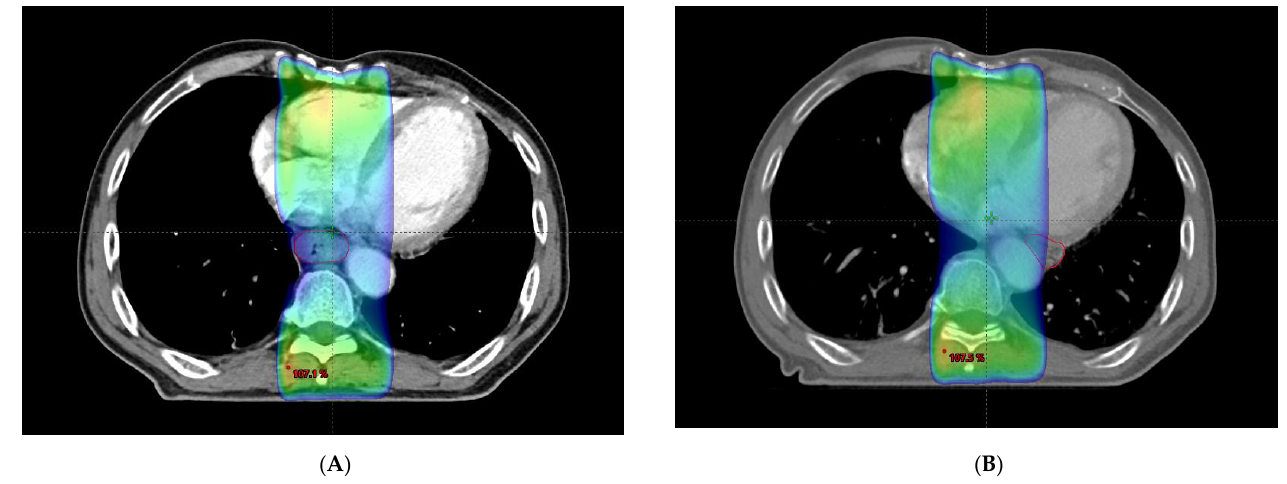
Figure 3. ( A ) Initial radiation plan. Esophagus (red line) is covered with 95% of prescription dose. (colored area). ( B ) Radiation plan with moved esophagus (red line). Part of esophagus was outside radiation field.